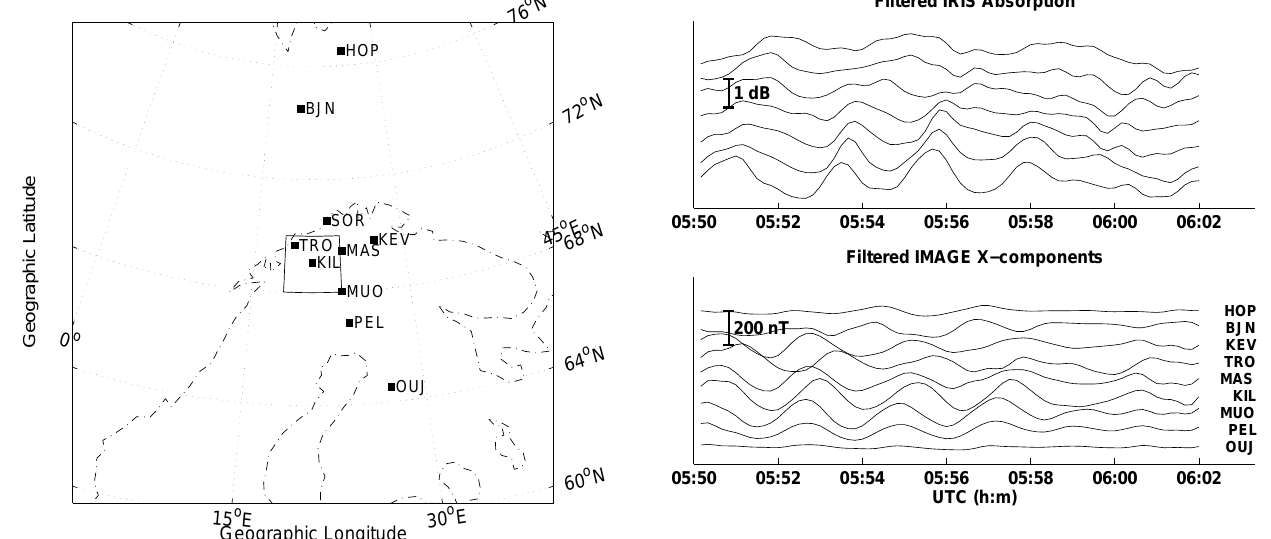
Fig. 2. Time series of Event 1 seen in absorption and magnetic X - components. North is at the top of each